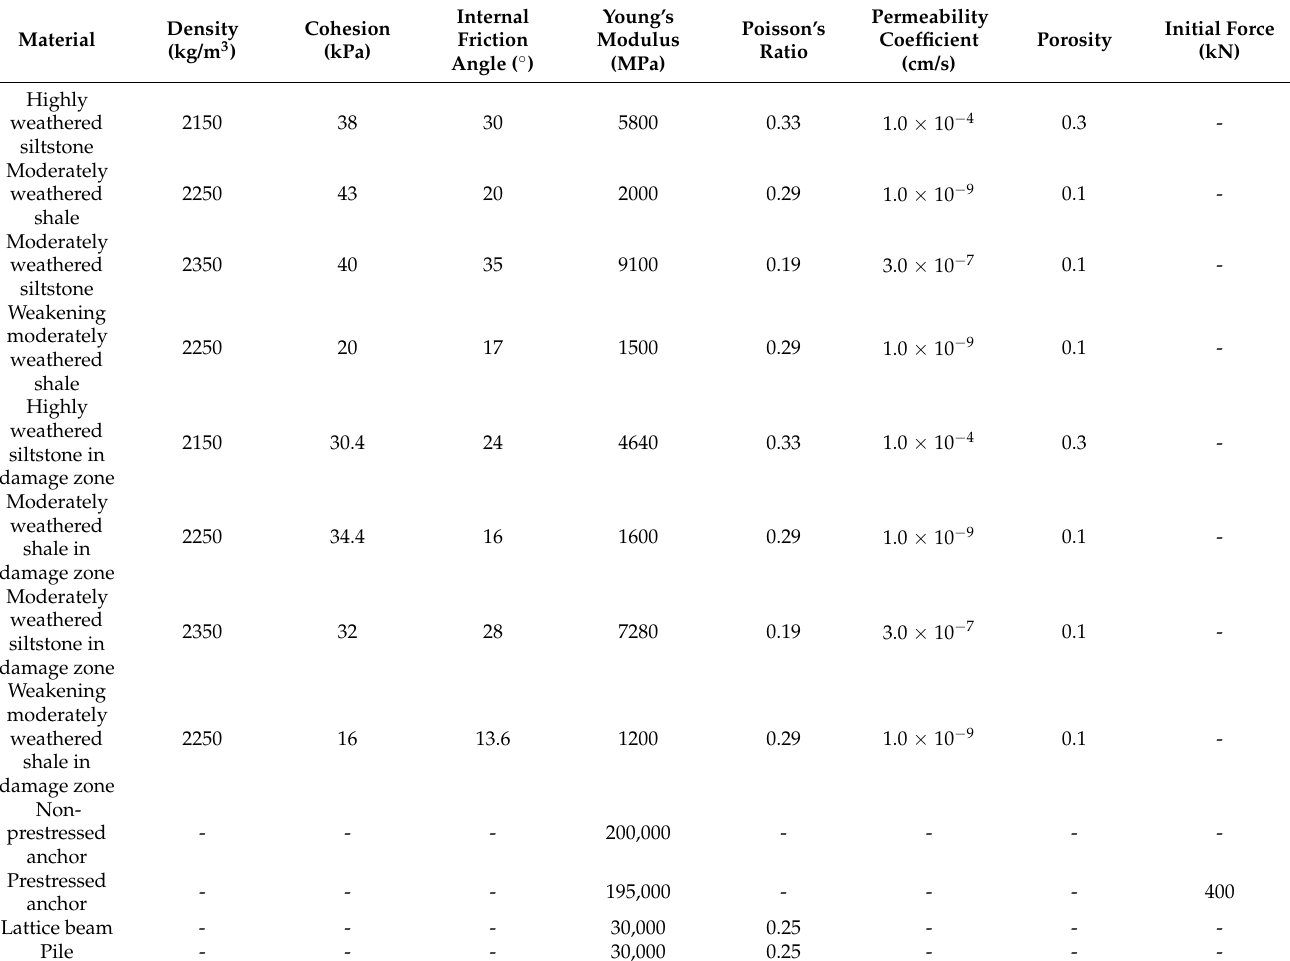
Table 1. Material properties used in the numerical